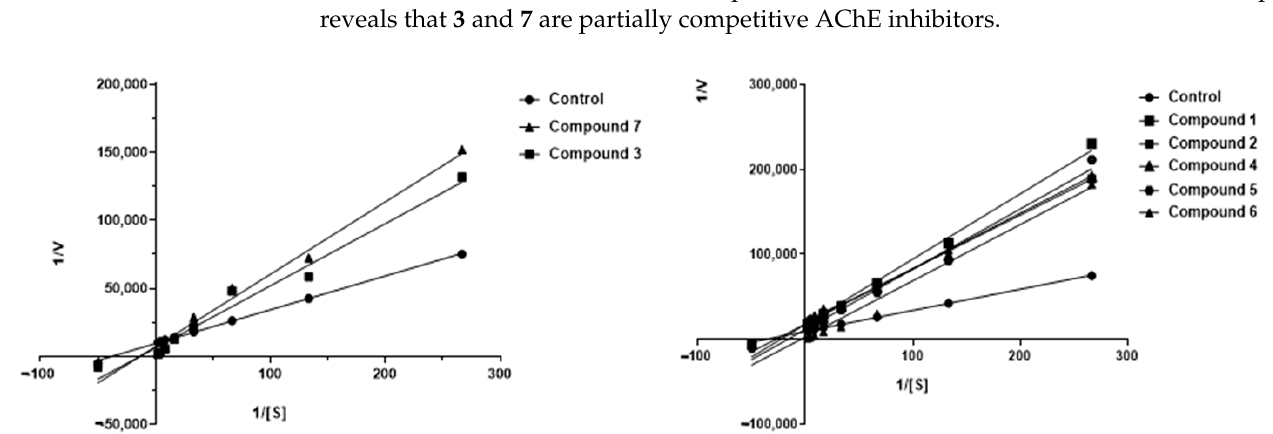
Figure 4. Kinetic study on the mechanism of AChE inhibition by ceanothane 2 ( ■ ), 3 ( ■ ), 6 ( ▲ ), 7 ( ▲ ), and control ( ● ). Overlaid Lineweaver–Burk reciprocal plots of AChE initial velocity at increas- ing substrate concentration (0.015–0.50 µM) in the absence of inhibitor and in the presences of dif- ferent concentrations of ceanothane 2 ( ■ ), 3 ( ■ ), 6 ( ▲ ), and 7 ( ▲ ). [AChE] = 0.25 U/mL.